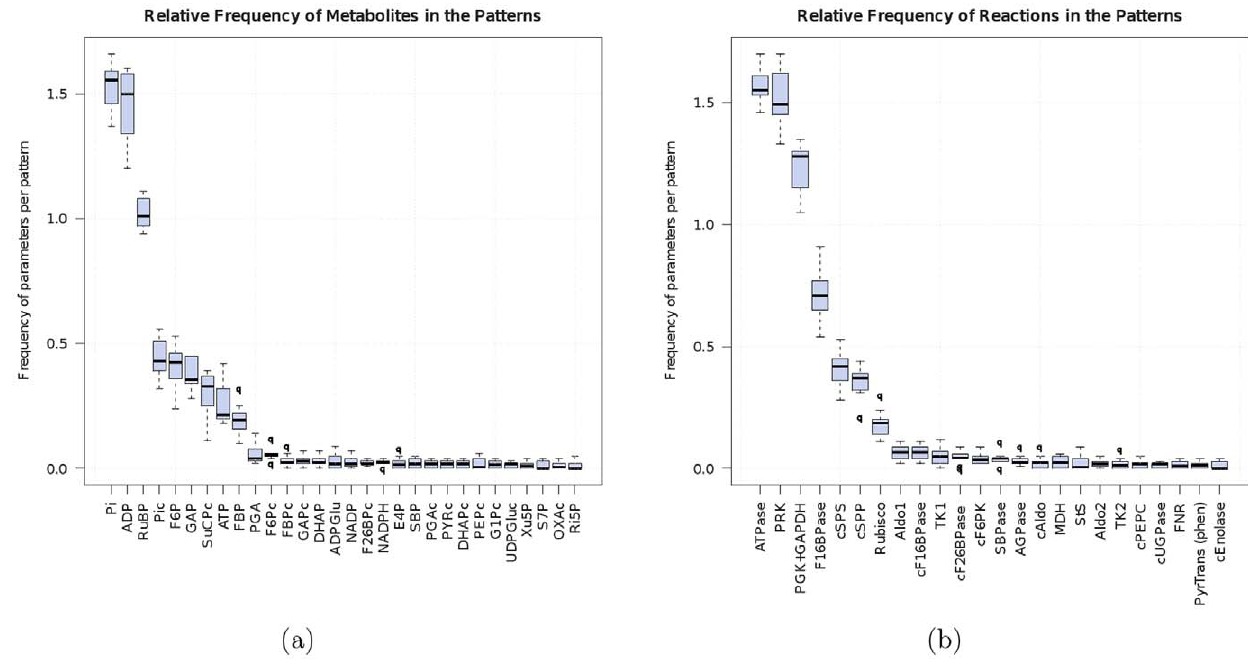
Figure 6. Relative frequencies of metabolites in the patterns. The boxplots show the occurrence frequencies of a) the metabolites and b) the reactions in the detected stability patterns with Laplace ratios § 0 : 99 in different cross-validation runs. Cytosolic reactions begin with a lowercase ‘c’.